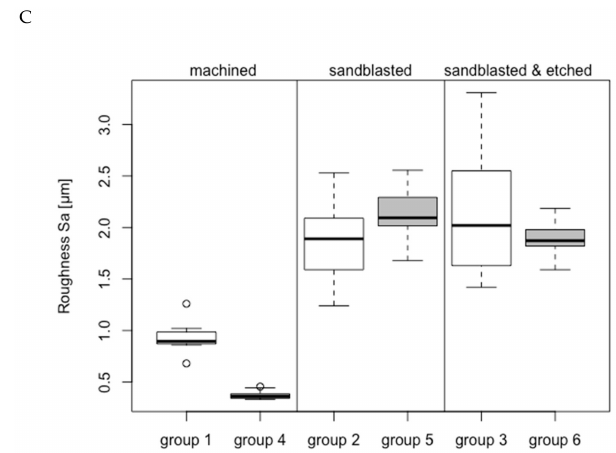
Figure 5. Box plots comparing ( A ) insertion torque, ( B ) cortical bone thickness, and ( C )